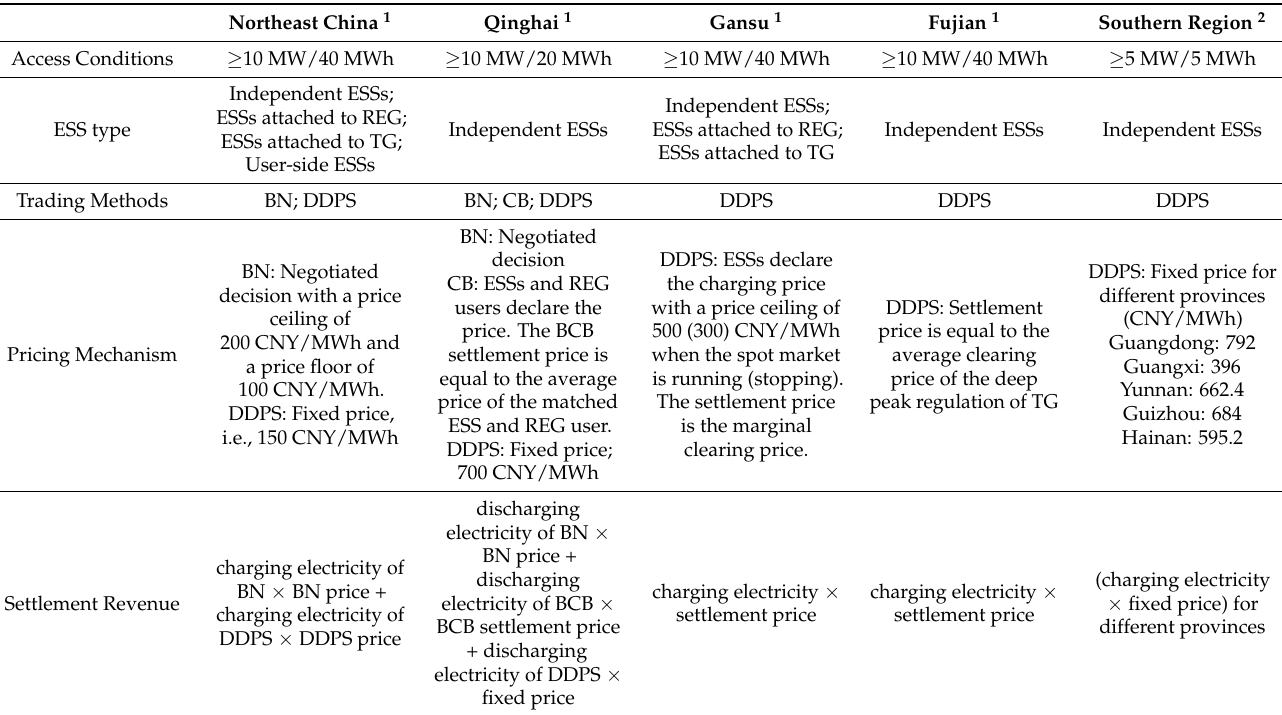
Table 1. Rules of ESSs for the peak-regulation ancillary service in typical regions and provincial administrative regions of